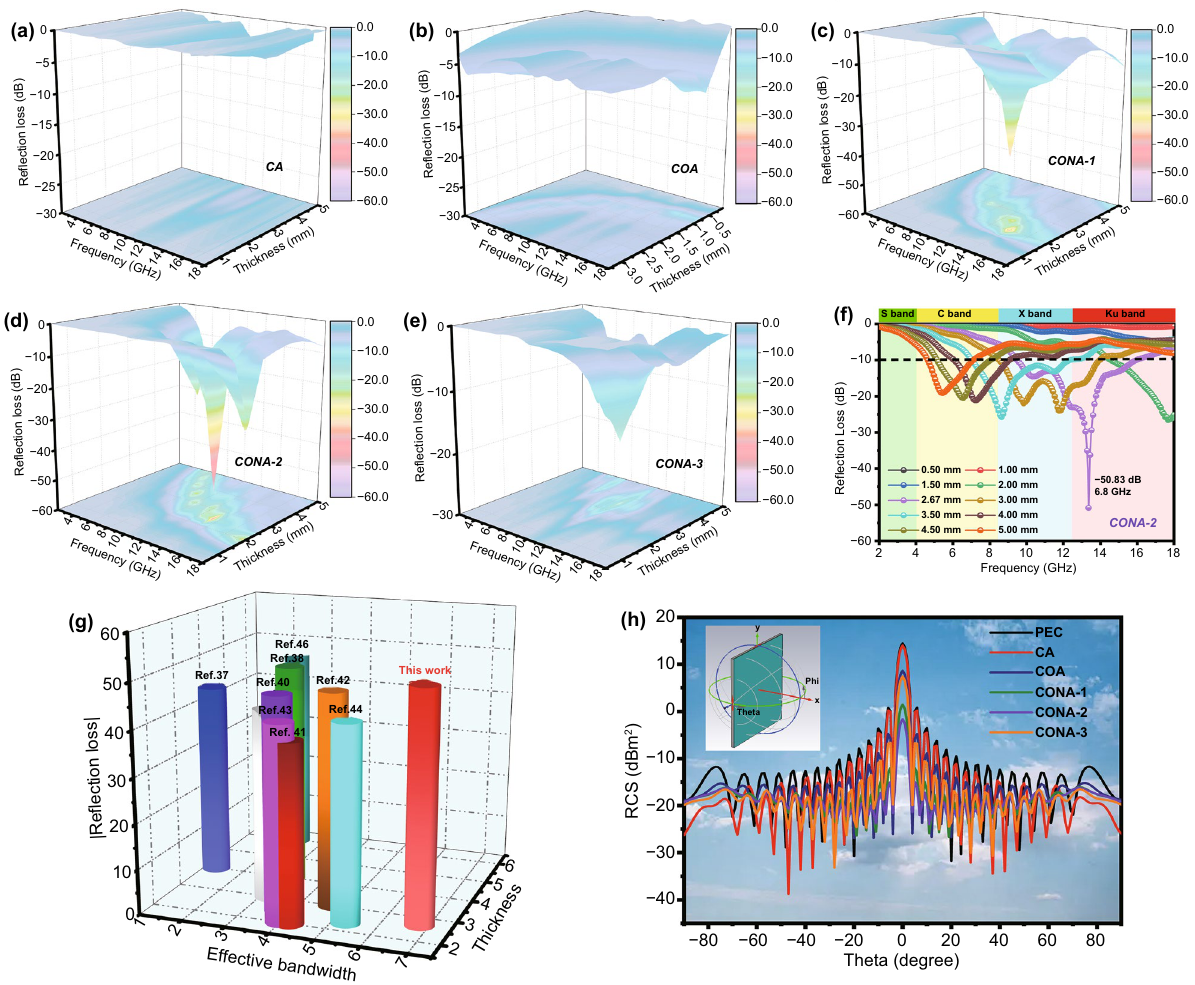
Fig. 5 3D RL performance of a CA, b COA, c CONA-1, d CONA-2 and e CONA-3 in 2–18 GHz range from 0.5–5.0 mm; f 2D RL perfor- mance of CONA-2; g EMW absorption performance in comparison of reported aerogel absorbers; h RCS simulated image of PEC contained composites with scanning angles from -90° to